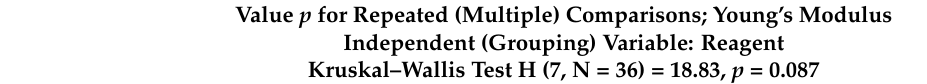
Table 5. Results of repeated (multiple) comparisons.